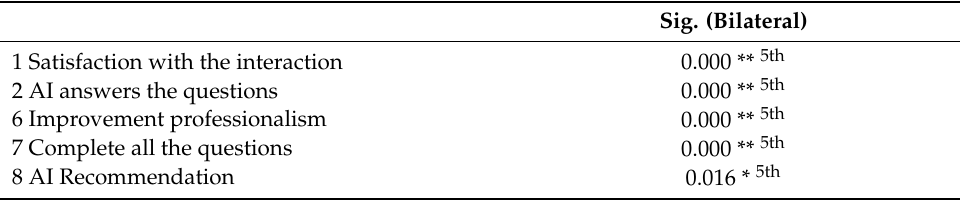
Table 6. Mann–Whitney U-test results.